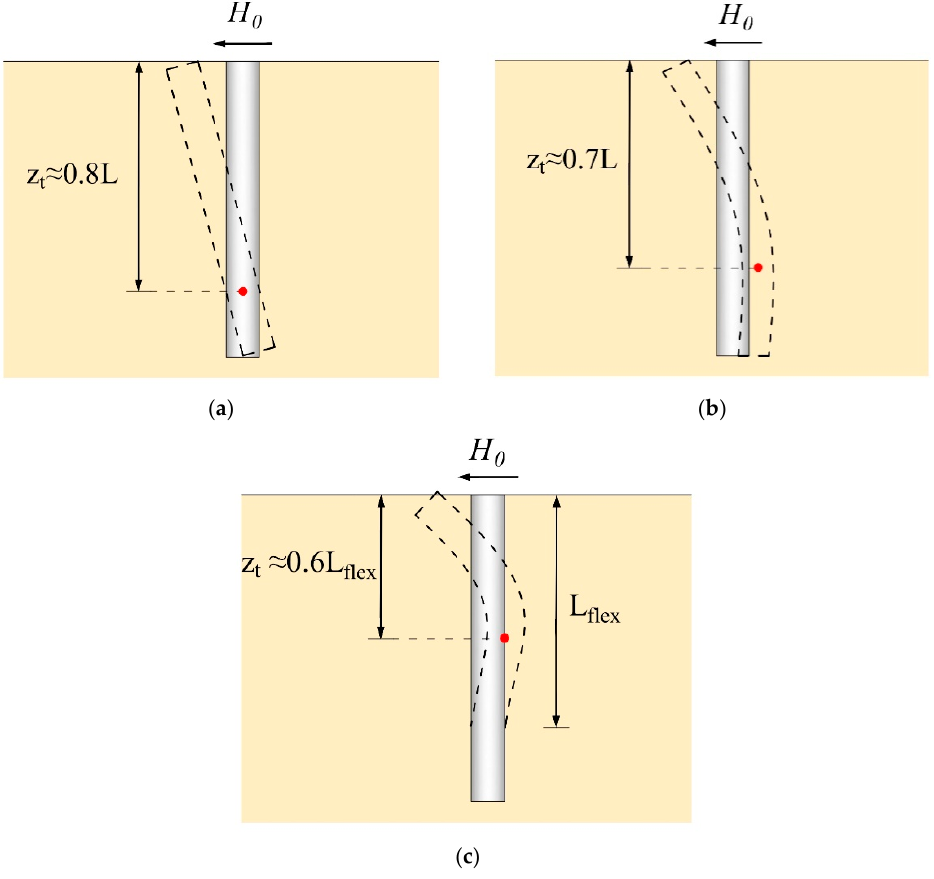
Figure 15. The depth ( 𝑧 (cid:3047) ) of the first turning point of pile for ( a ) a rigid pile, ( b ) a elastic pile and ( c ) a flexible pile. flexible